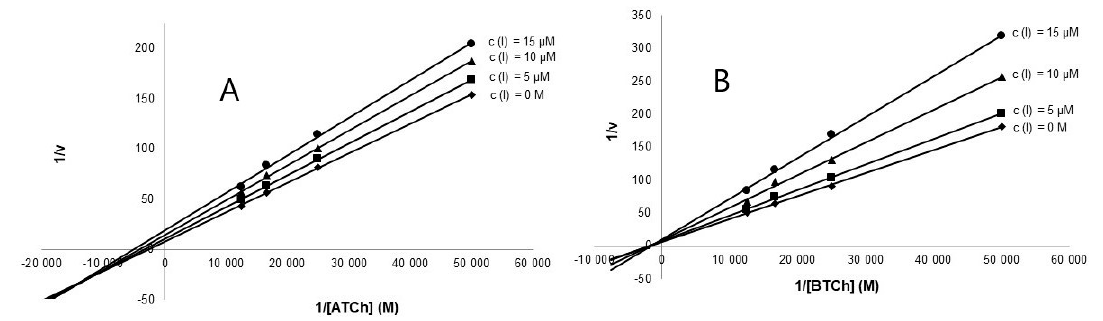
Figure 2. ( A ) Lineweaver-Burk plot of 1/v vs. 1/[acetylthiocholine] in the presence or absence of 1j; ( B )-Lineweaver-Burk plot of 1/v vs. 1/[butyrylthiocholine] in the presence or absence of 1j ‐ B.